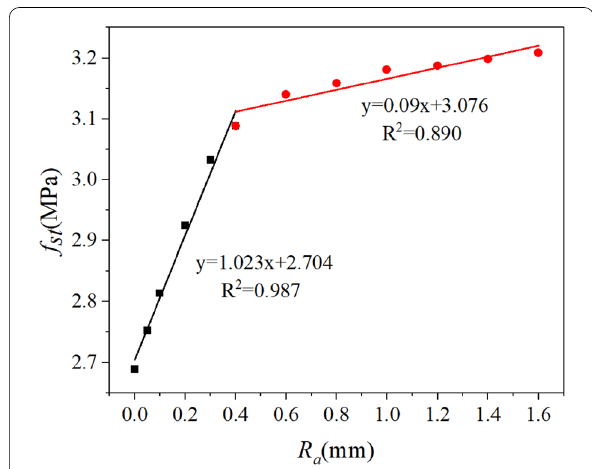
Fig. 17 Variation of tensile strength with aggregate surface roughness